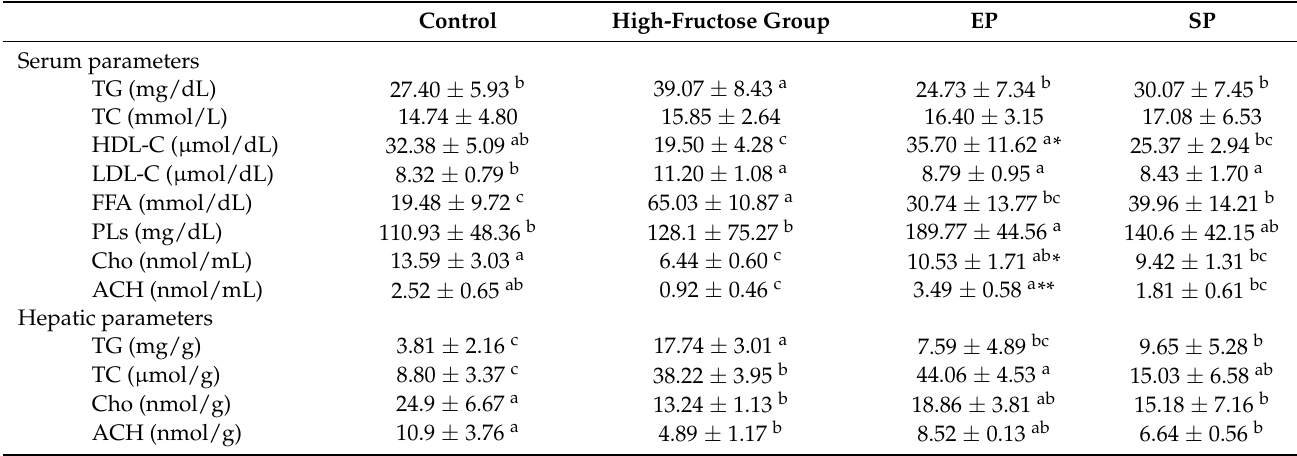
Table 3. Serum and hepatic lipids in each group.